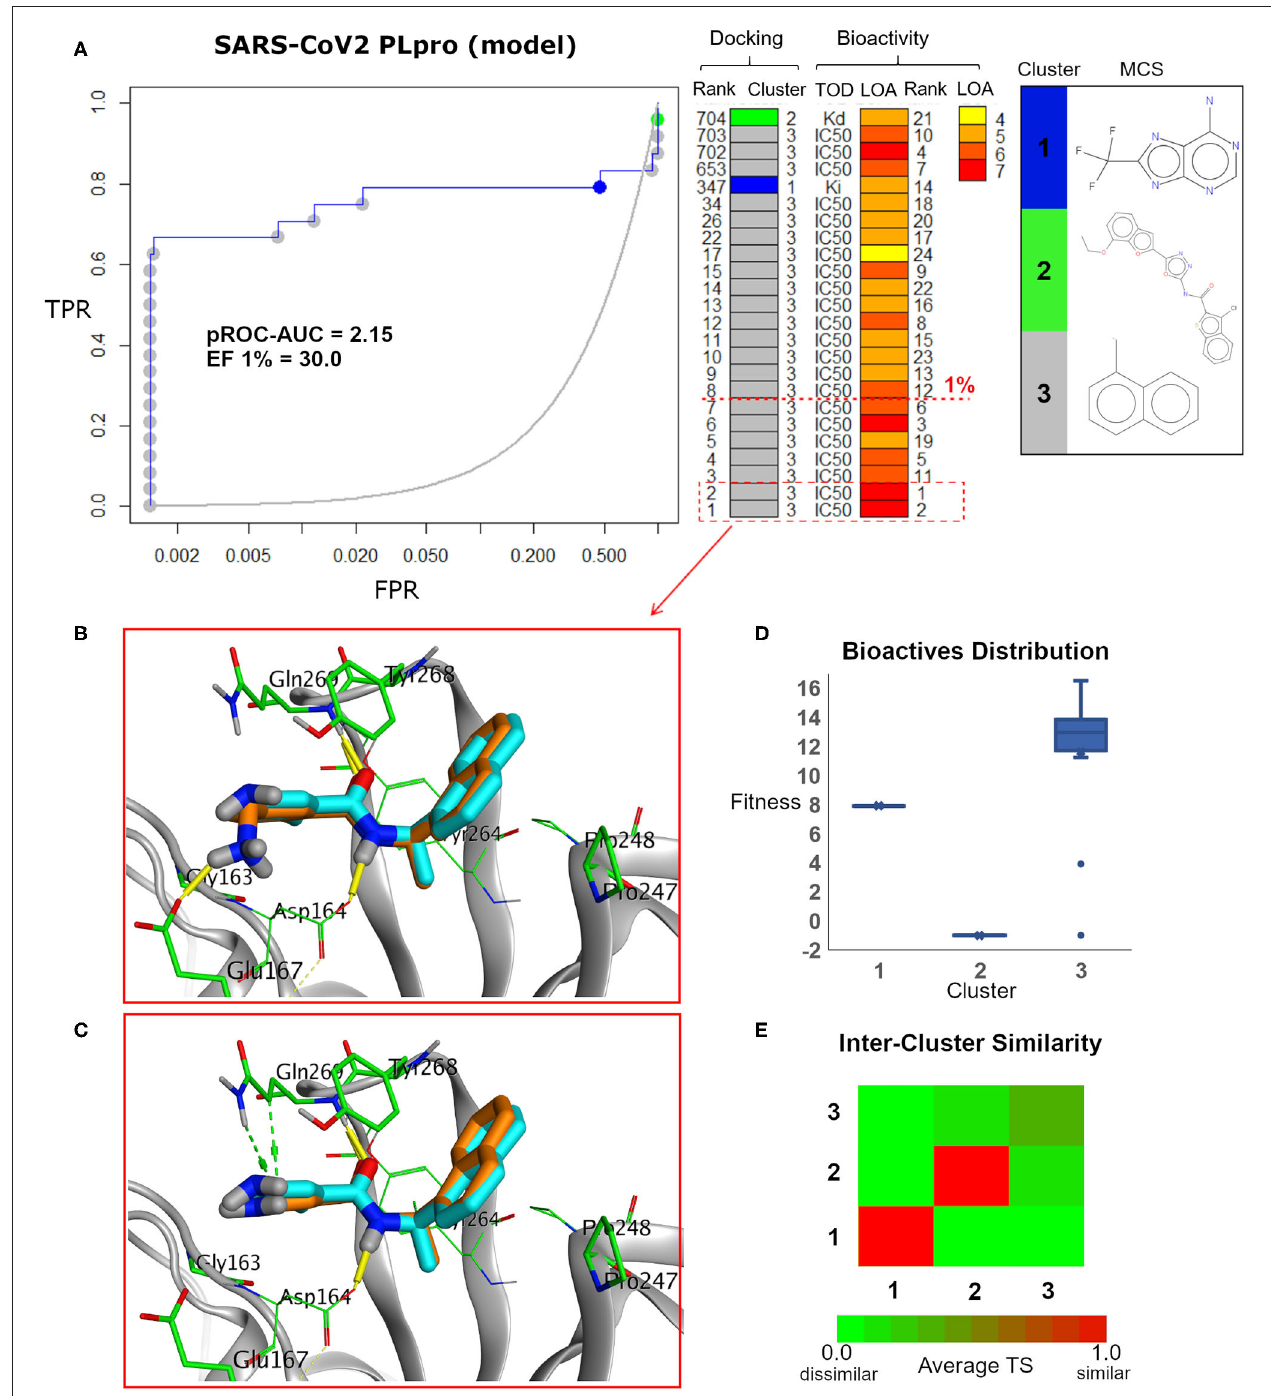
FIGURE 7 | (A) pROC-Chemotype plot (Ibrahim et al., 2015b) of the SARS-CoV-2 PLpro model using the FRED docking tool. The docking information is matched with the chemotype represented by the cluster number and the bioactivity information. The bioactivity information is represented as the rank of the ligand bioactivity, where the color scales from yellow (less potent) to red (more potent). The red-dashed line indicates an enrichment of bioactives as at the 1% database. Enrichment Factor (EF) evaluates the capability of the docking tool to find true positives in the score-ranked list compared to the random selection. EF is calculated based on the / Bioactives total succeeding equation (Wei et al., 2002) EF = Bioactives subset . (B,C) The best docking and the second-best docking poses of the bioactive set overlaid on the N subset N total model ligand as orange and cyan sticks, respectively. (D) Box plot of the fitness vs. chemotype clusters illustrating the bioactive molecules distribution. Fitness is expressed as the FRED score multiplied by − 1 for comparison purposes. (E) Heat map of the three chemotype clusters of the SARS-CoV PLpro benchmark set based on the average Tanimoto similarity (Ts) over all cross-cluster pairs. The color gradient represents changes in the average Ts. Green indicates maximum dissimilarity (Ts ≈ 0), and red indicates maximum similarity (Ts = 1).